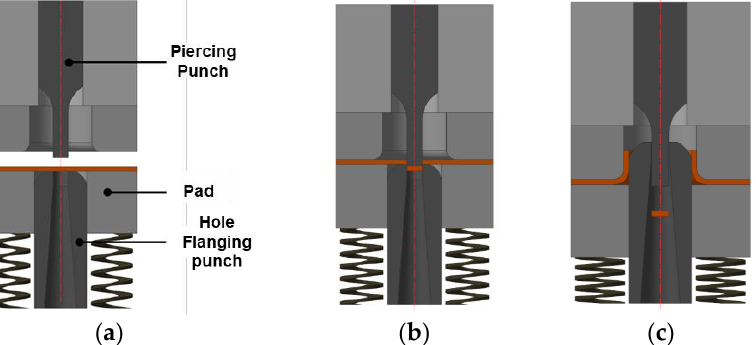
Figure 1. Concept of high-temperature, simultaneous piercing and hole-flanging process; ( a ) initial stage; ( b ) pilot hole piercing process; ( c ) hole-flanging process.